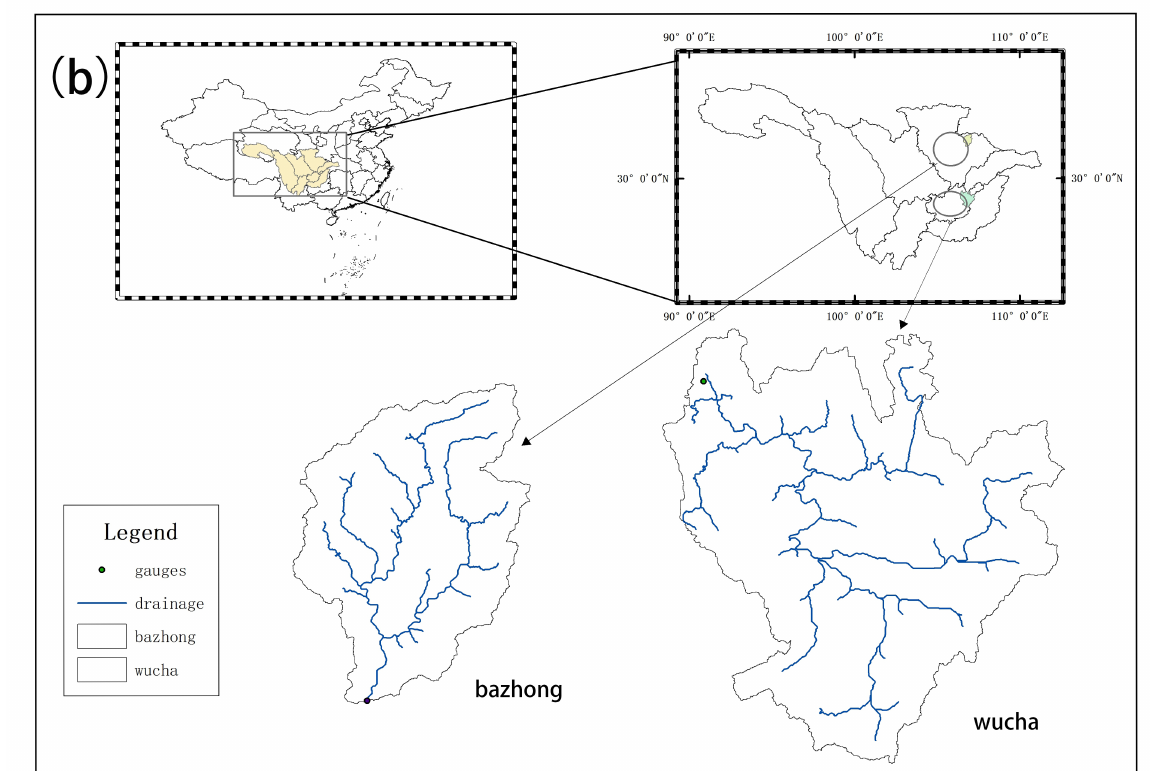
Figure 1. Map of study area. ( a ): location of 196 catchments in the CAMELS data set that are suitable for simulation using the Xin’anijang hydrological model; ( b ): location of two catchments in Jialing River Basin,